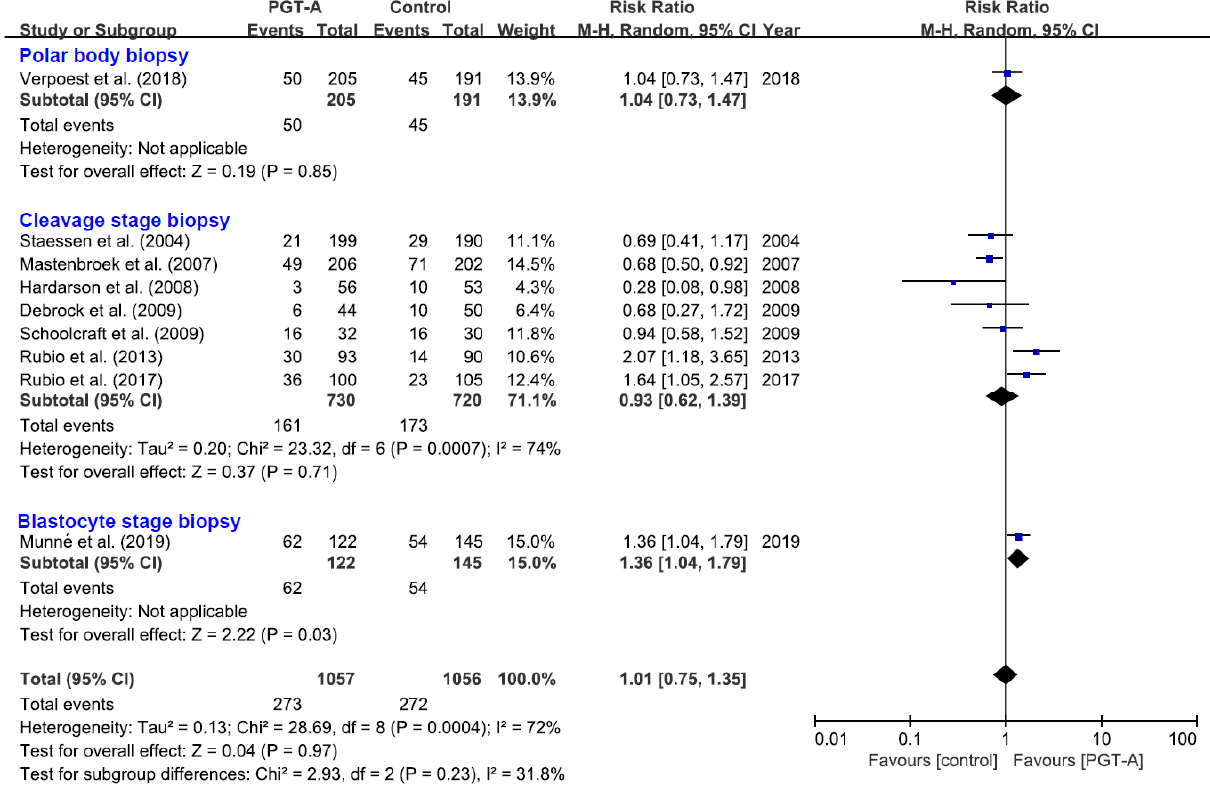
Figure 3. The effect of PGT-A with different stages of embryo biopsy on live birth rate. Each study represented by a line. The square represents the point estimate of the effect for a single study, and its area is proportional to the weight of the study. The diamond represents the pooled effect estimate and the width of the diamond represents the 95% CI around this estimate.